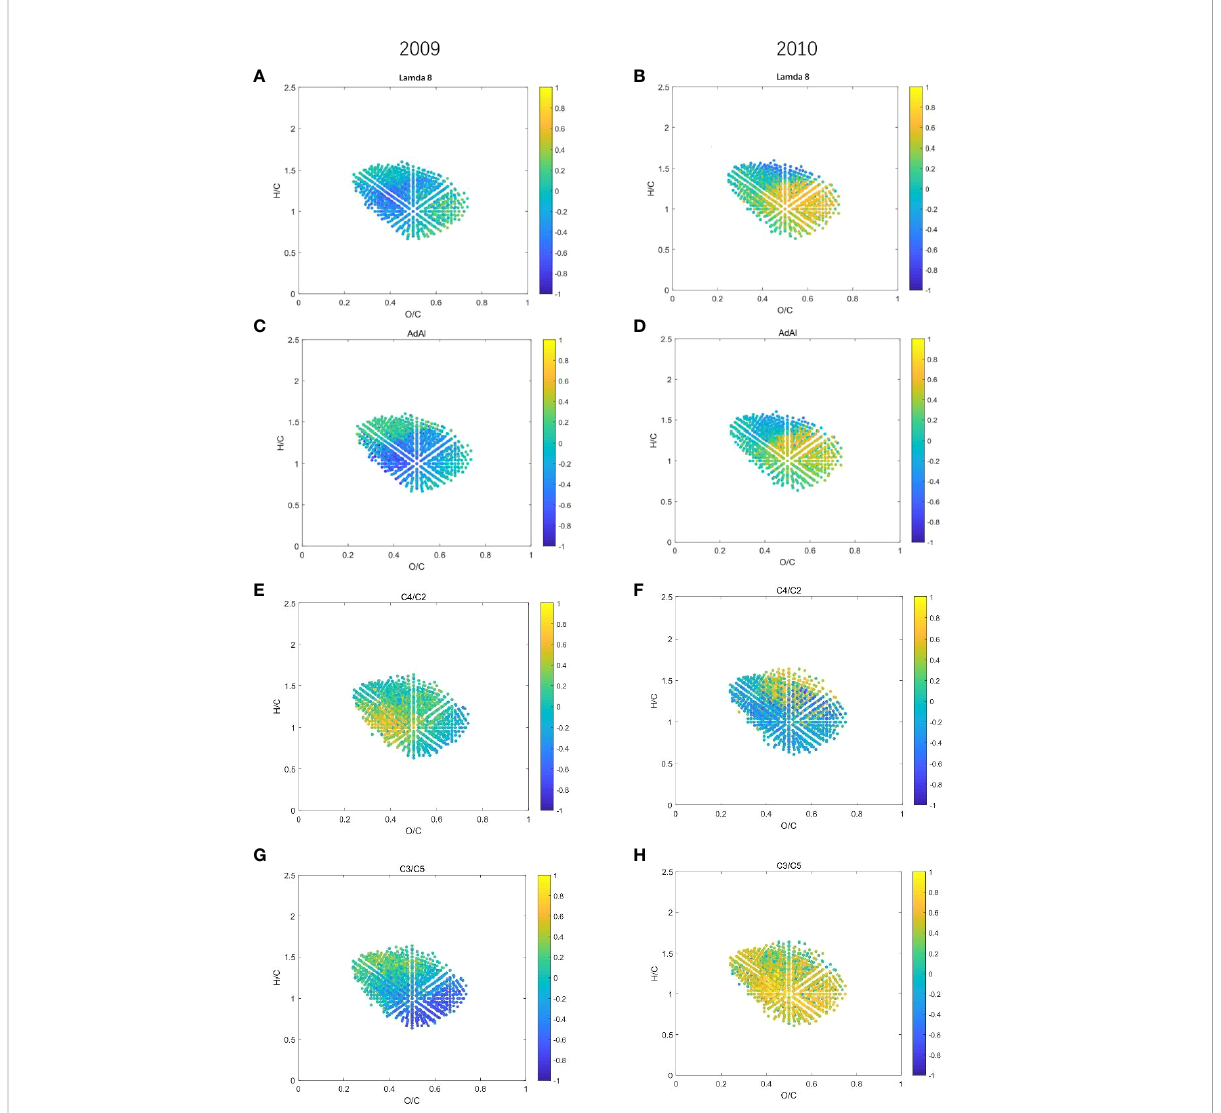
FIGURE 4 van Krevelen diagram: Colors represent the Spearman correlation coef fi cient for three parameters tested against relative intensity change of each molecular formula in the data set. Correlation analyses were performed for 2009 (left panels) and 2010 (right panels) samples. (A B) : L 8 vs CHO formulas; (C D) : (Ad/Al) v vs CHO formulas; (E, F) : C4/C2 vs all formulas; (G, H) : C3/C5 vs all